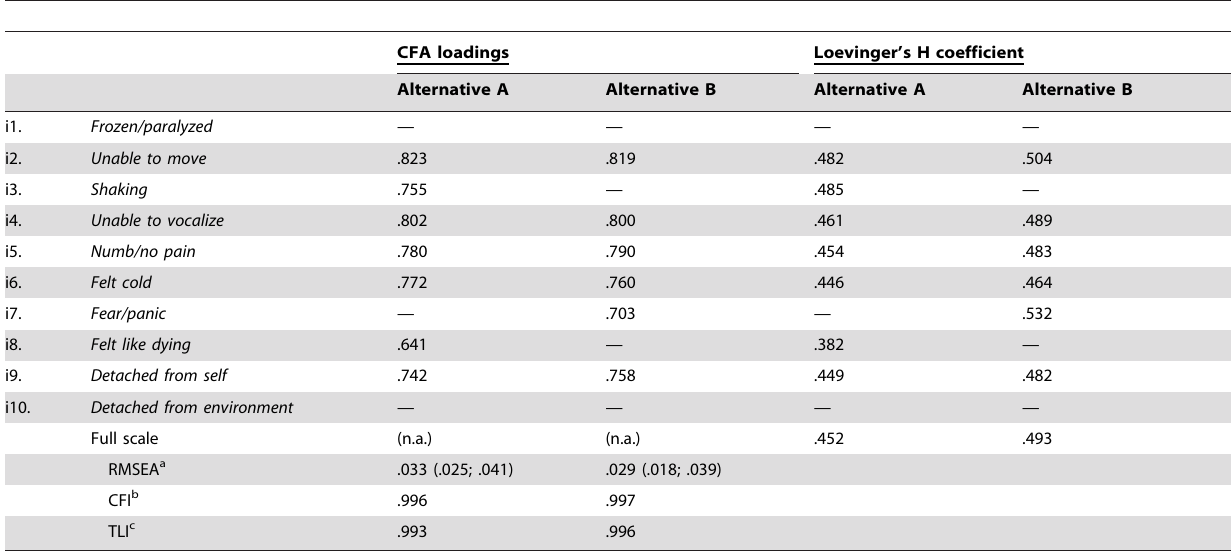
Table 4. Alternative restricted models applied to the Rio de Janeiro sample excluding Tonic Immobility Scale’s redundant items: